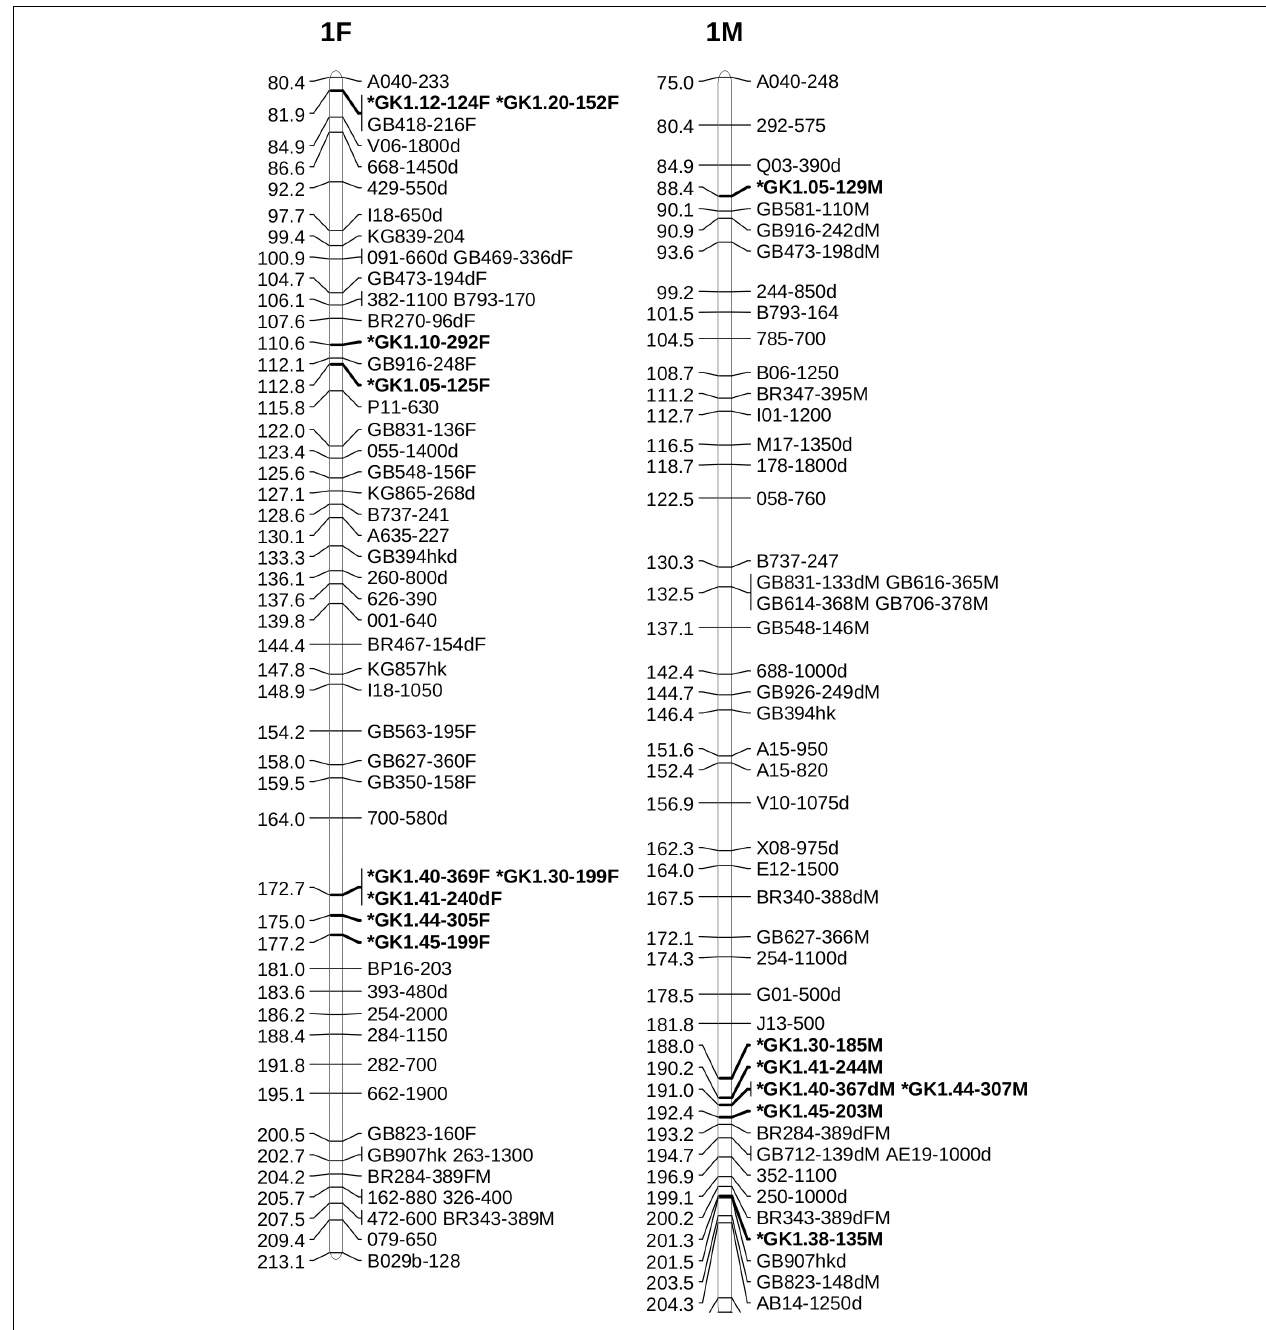
FIGURE 1 | Maps of linkage group 1 (LG1) of female parent OSU 252.146 (left) and resistant parent OSU 414.062 (right) in the reference mapping population for hazelnut ( Corylus avellana ) with new simple sequence repeat markers indicated by *. Units are centimorgans